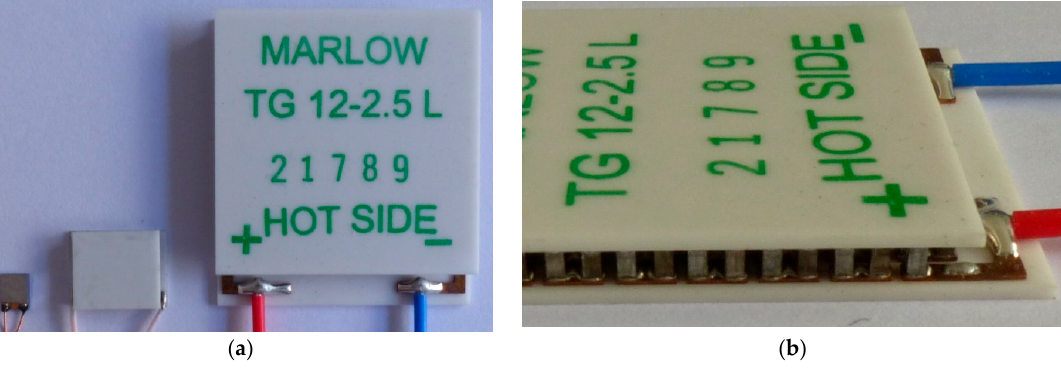
Figure 3. ( a ) Three different thermoelectric generators with a surface area of 3 mm × 3 mm, 10 mm × 10 mm and 30 mm × 30 mm; ( b ) Details of a big bulk-TEG.